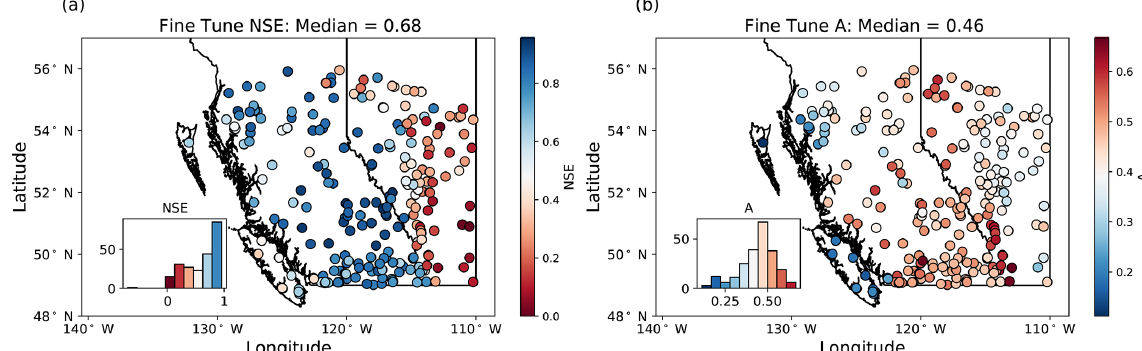
Figure 4. The NSE (a) and sensitive area A (b) , as calculated over the test period for the fine-tuned model ensemble mean. The insets show histograms of NSE and A across all stations. NSE values are the greatest (indicating the best model performance) throughout mainland British Columbia and are smallest (indicating the worst model performance) in southeastern Alberta. A is smallest (indicating small sensitive areas) in the southwestern and northwestern coastal regions in British Columbia and is largest (indicating large sensitive areas) throughout the rest of British Columbia and near the Alberta border. The colour map in panel (a) is clipped at NSE = 0 for better visualization and is justified since only two stations have NSE <